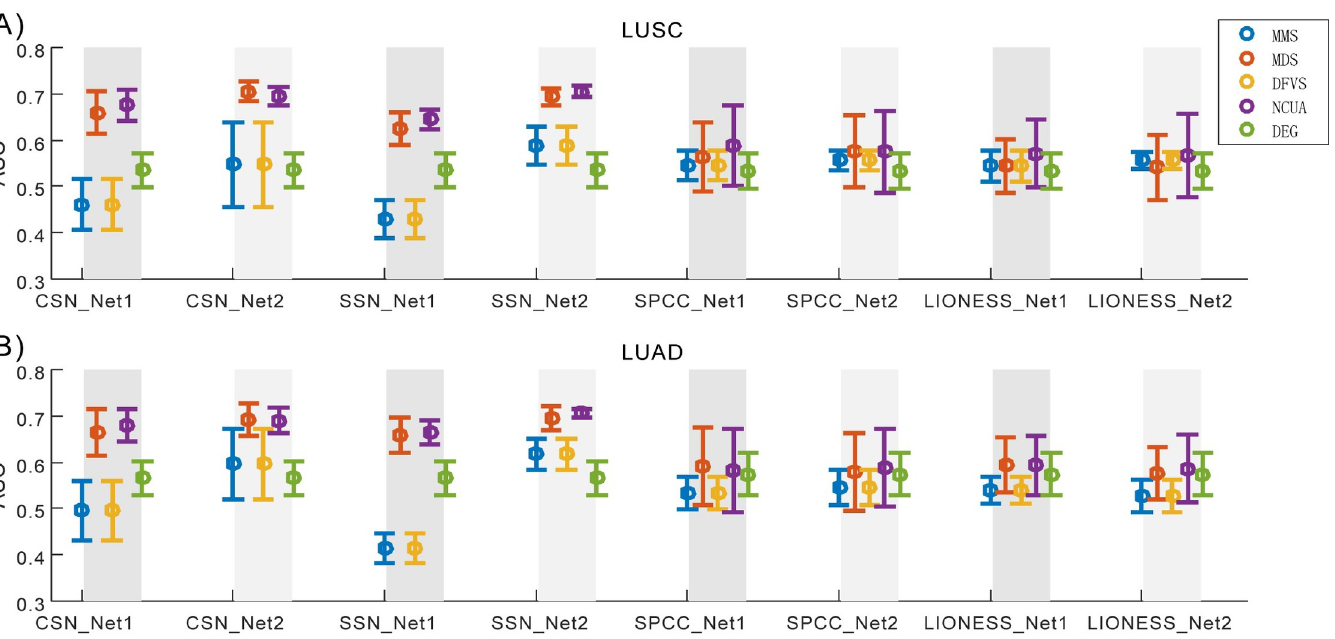
PLOS Computational Biology | https://doi.org/10.1371/journal.pcbi.1008962 May 6,